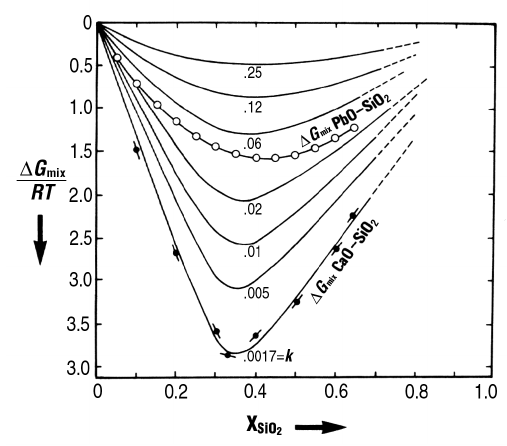
Fig. 3. ∆ G mix for the systems CaO-SiO 2 and PbO- SiO 2 . Data compared with theoretical curves calcu- lated using the Toop and Samis quasi -chemical mod- el (after Toop and Samis,